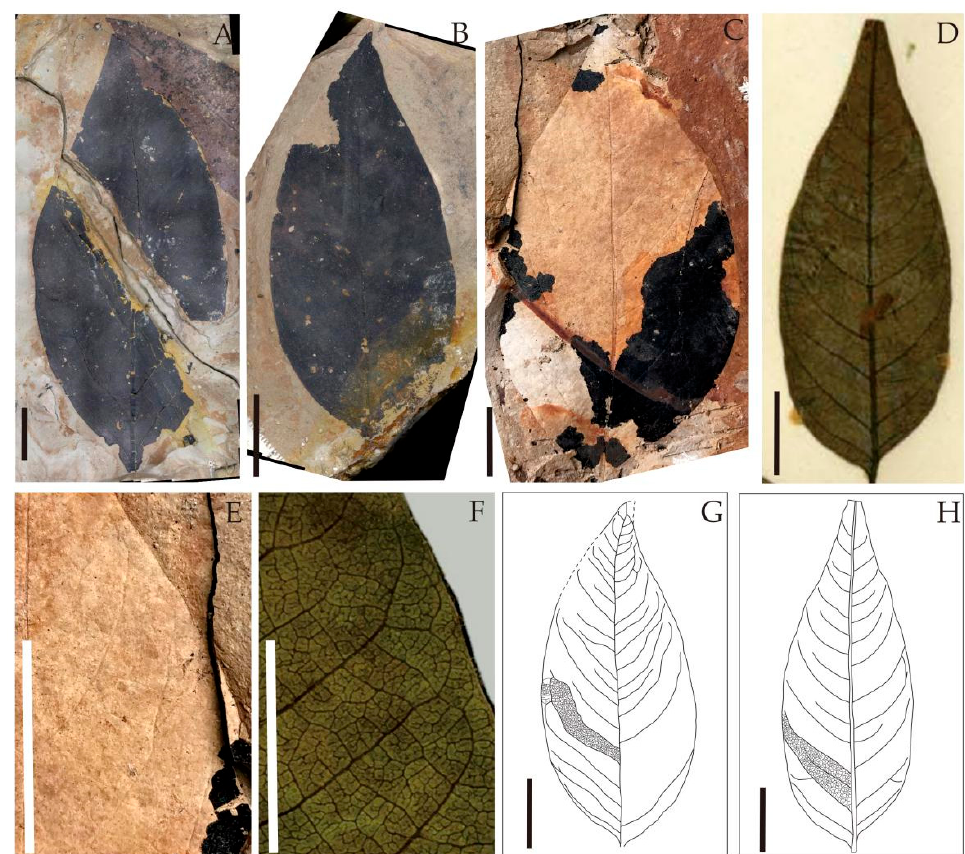
Figure 6. Leaf architecture of the extant and fossil Choerospondias (( A ), GT-14-629; ( B ), GT-14-468; ( C ), DLC-14-100A). ( A – C ): Fossil Choerospondias . ( D ): Extant Choerospondias . ( E ): Leaf margin of fossil Choerospondias . ( F ): Leaf margin of the extant Choerospondias . ( G ): Sketch of fossil Choerospondias. ( H ): Sketch of the extant Choerospondias . Scale bar = 1 cm.